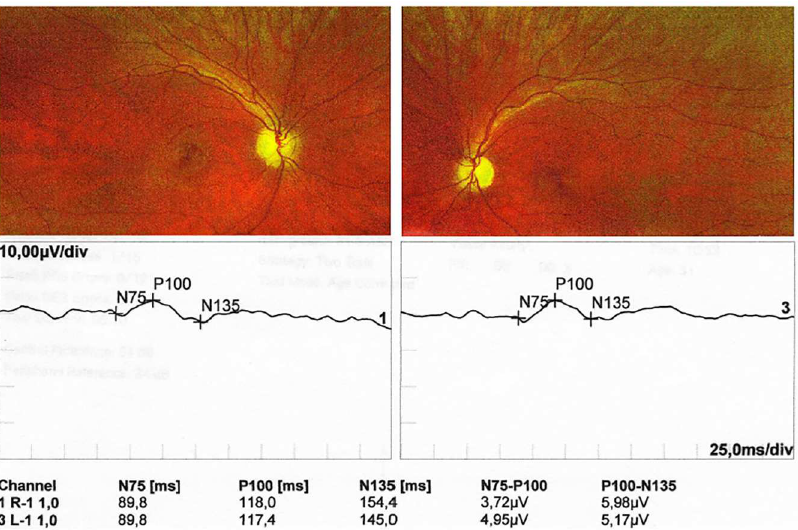
Fig 1. Characteristic featureson ophthalmological evaluation in the proband from family A. Fundus examination showedbilateraltemporalpallor of the optic disc. PVEP presented a reducedamplitudeand delayedlatency of P100 wave. Componentsof PVEP, N75, P100 and N135, indicate polarity (negative or positive)and absolutelatencies(msec) of the peaks waveforms. Right panel—left eye, left panel—right eye.